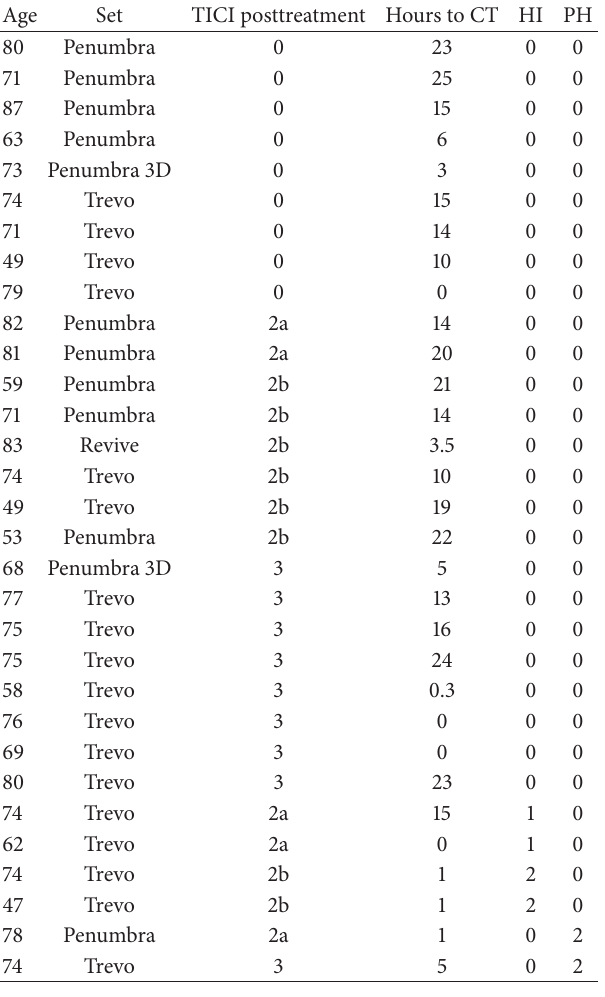
Table 1: Patient data and HI and PH in comparison to published